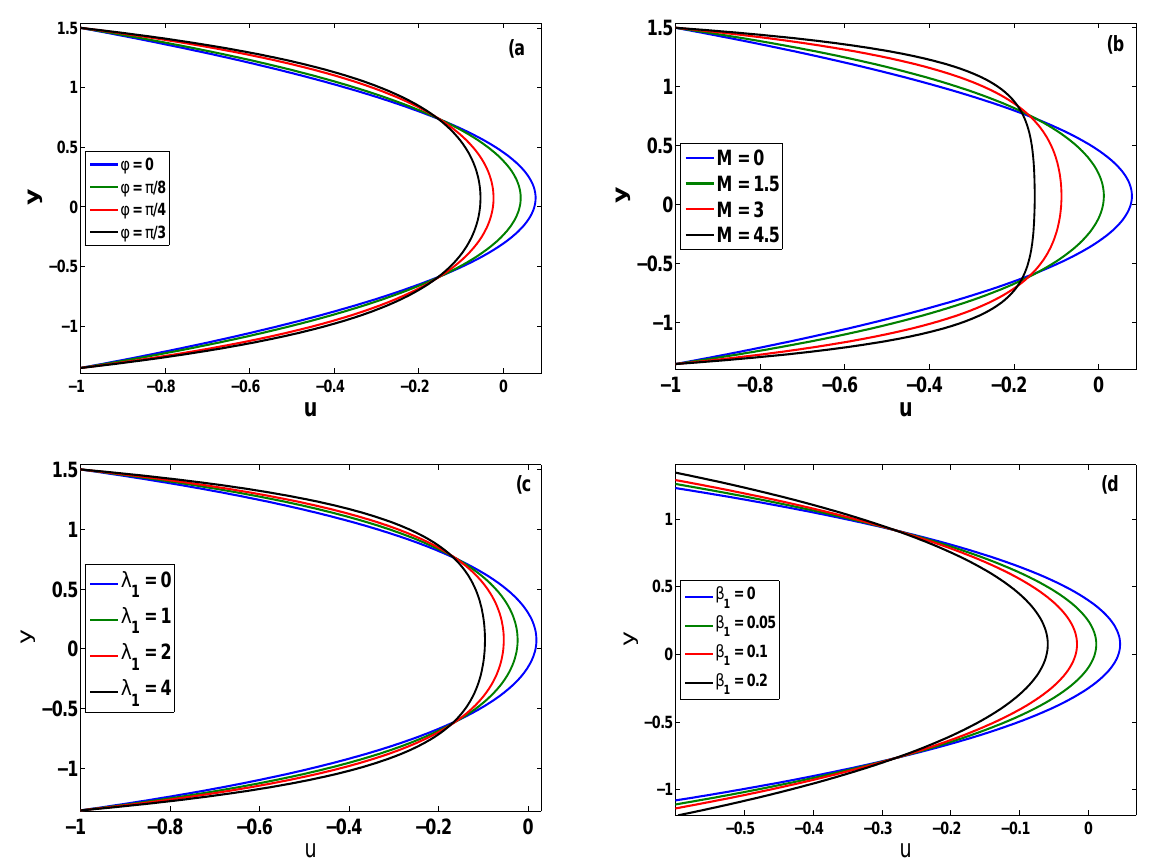
Figure 4. Distribution of velocity( u ) vs y for x = 0, Q = 1.2, ( a ) : M = 4, β 1 = 0.2 λ 1 = 1, ( b ) : ϕ = π /4, β 1 = 0.2, λ 1 = 1, ( c ) : ϕ = π /4, β 1 = 0.2, M = 4 , ( d ) : M = 4, λ 1 = 1, ϕ = π